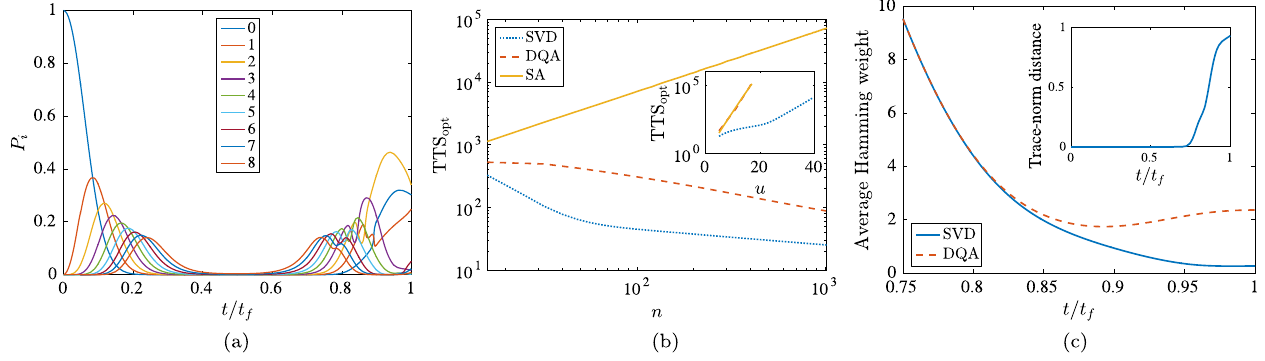
FIG. 6. Diabatic QA verus SA and SVD for the fixed plateau problem with l ¼ 0 . (a) Population P in the i th energy eigenstate along i the diabatic QA evolution at the optimal TTS for n ¼ 512 and u ¼ 6 . Excited states are quickly populated at the expense of the ground 0 . 5 the entire population is outside the lowest nine eigenstates. In the second half of the evolution the energy eigenstates state. By t=t f ¼ are repopulated in order. This kind of dynamics occurs due to a lining up of avoided-level crossings as seen in Fig. 7. (b) Scaling of the optimal TTS with n for u ¼ 6 , with an optimized number of single-spin updates for SA, and equal ð t for DQA and SVD. SA scales f Þ opt as O ð n Þ , a consequence of performing sequential single-spin updates. DQA and SVD both approach O ð 1 Þ scaling as n increases. Here, 0 . 7 in Eq. (14), in order to be able to observe the saturation of SVD ’ s TTS to the point where a single run suffices, i.e., we set p d ¼ t TTS . The conclusion is unchanged if we increase p : this moves the saturation point to larger n for both SVD and DQA, and f Þ opt d opt ¼ ð we have checked that SVD always saturates before DQA. Inset: Scaling as a function of u for n ¼ 1008 . SVD is again seen to exhibit the best scaling, while for this value of n the scaling of DQA and SA is similar (DQA ’ s scaling with n improves faster than SA ’ s as a function of n , at constant u ). (c) h HW i of the QA wave function and the SVD state (defined as the product of identical spin-coherent states) for ≈ 0 . 8 , when they begin to differ significantly, but neither displays any n ¼ 512 and u ¼ 6 . The behavior of the two is identical up to t=t f of the sharp changes observed in Fig. 2(c) for the instantaneous ground state. Inset: The trace-norm distance between the DQA and SVD ≈ 0 . 8 states, showing that they remain almost indistinguishable until t=t f